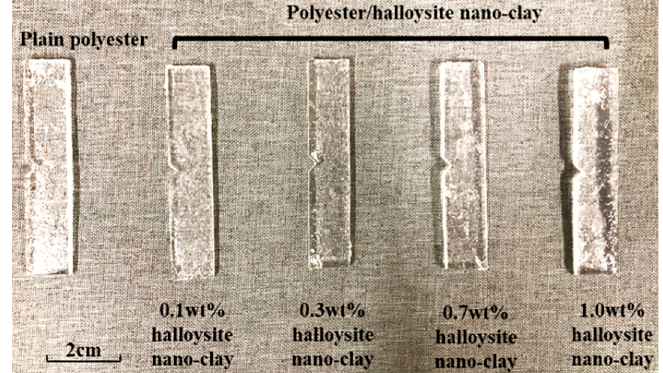
Figure 5. Workpiece prepared for micro milling experimentation.